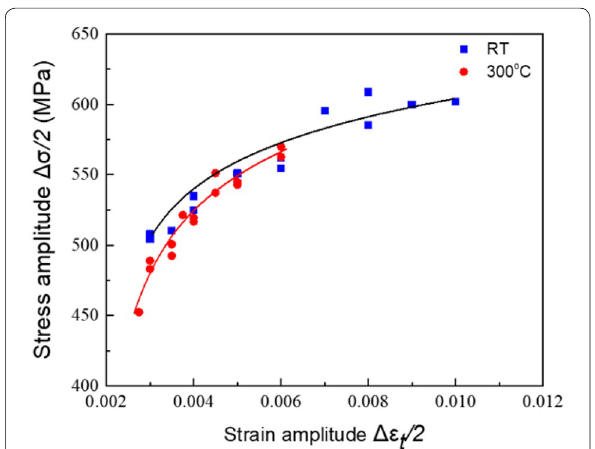
Figure 3 Strain amplitude-life curves at two different